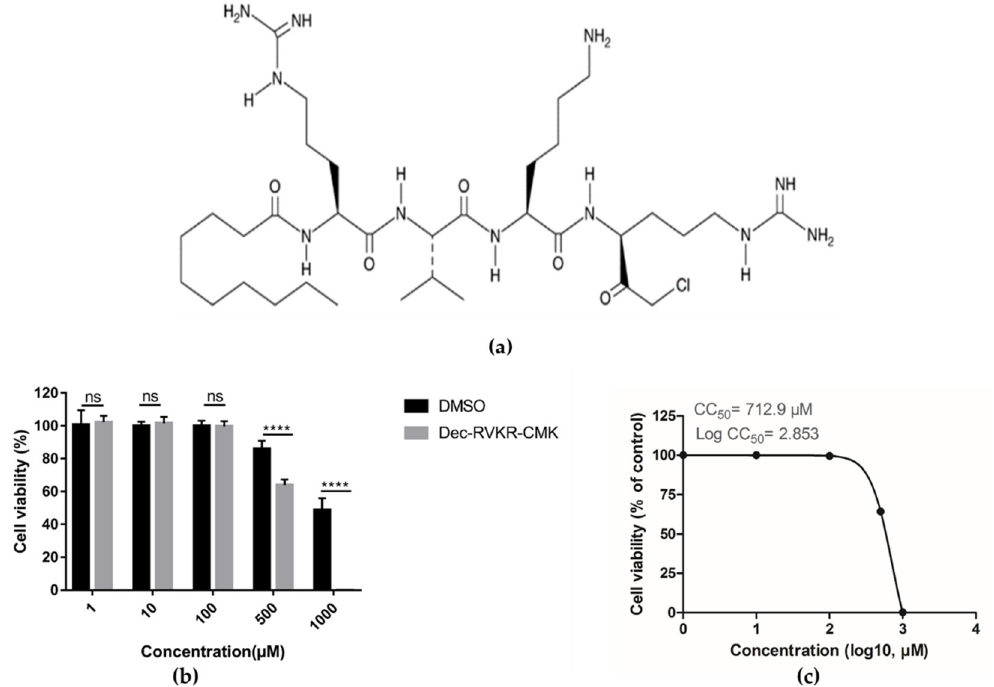
Figure 1. Determination of cytotoxicity of dec-Arg-Val-Lys-Arg-cmk on Vero cells. ( a ) Chemical structure of dec-RVKR-cmk. ( b ) Cytotoxicity of dec-RVKR-cmk on Vero cells determined by CellTiter-GLO One Solution Assay kit (Promega). ( c ) The CC50 value was calculated from GraphPad Prism using non-linear regression analysis. Data are presented as mean ± SEM from three independent experiments.